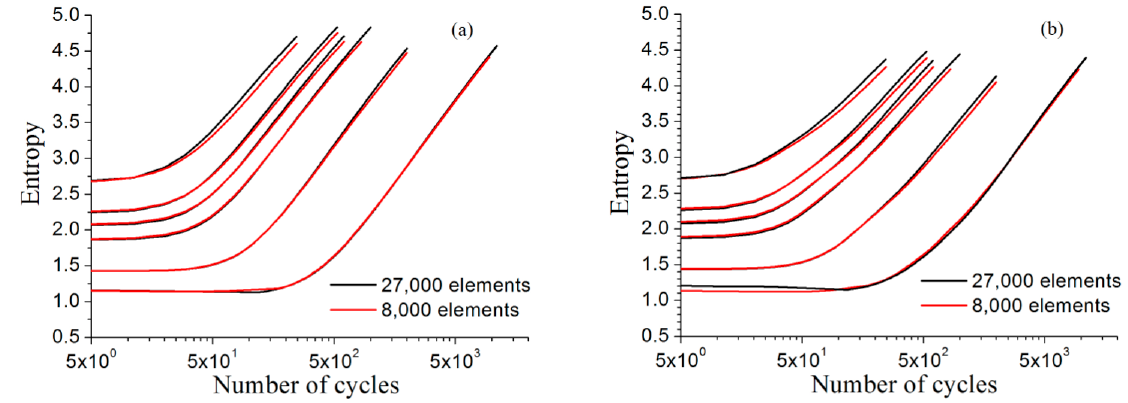
Figure 12. Comparison of the results of entropies calculated from the RVE models with different mesh